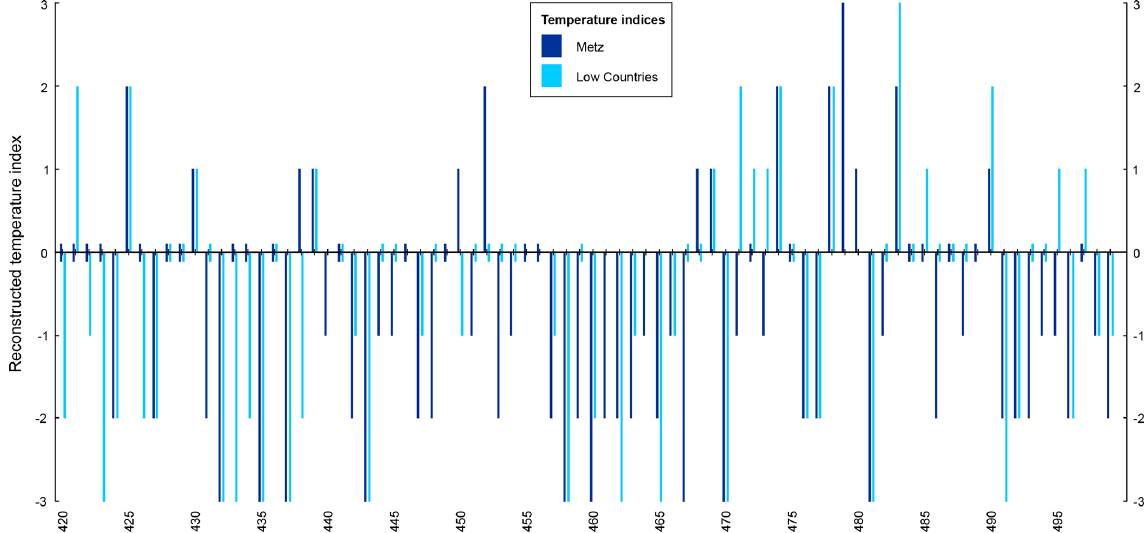
Figure 2. Comparison of seven-point winter temperature indices for Metz (Litzenburger, 2015) and the Low Countries (Belgium, Luxem- bourg, and the Netherlands; Camenisch, 2015a) for the 1420–1500CE period, reconstructed using the Pfister index approach. Zero values for specific years are indicated by a small